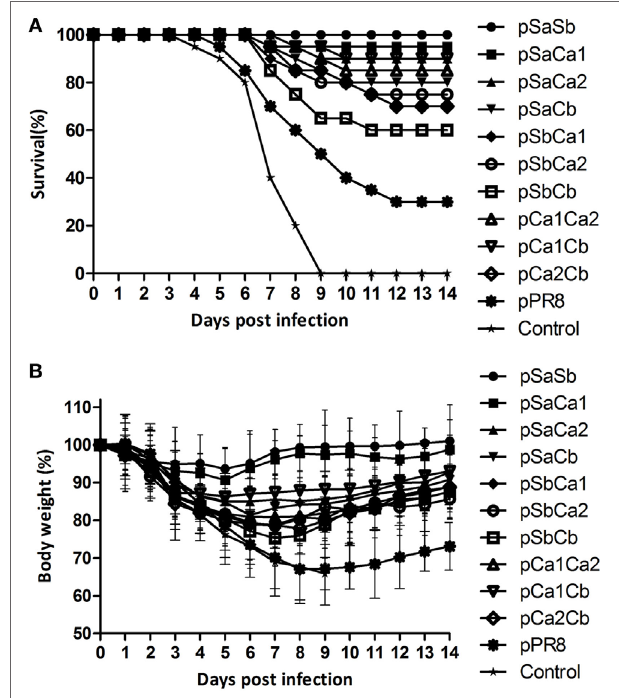
FigUre 4 | Survival and body weight of mice immunized with plasmid DNAs substituted with two epitopes of the Pdm09 HA. Female BALB/c mice (6–8 weeks old) were immunized twice, at an interval of 3 weeks, with 30 µg of plasmid DNAs substituted with two epitopes of the Pdm09 HA. Two weeks after the boost, mice were challenged with a lethal dose (20 × MLD 50 ) of mouse-adapted Pdm09 virus and monitored for survival and body weight for 14 days. (a) For Survival and (B) for body weight, error bars show the SD of each group.